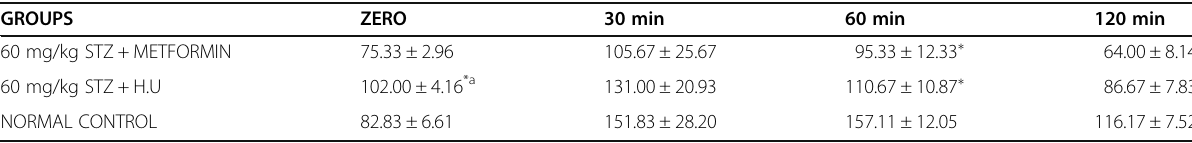
Table 3 Effect of H. umbellata on oral glucose tolerance test in non-diabetic rats